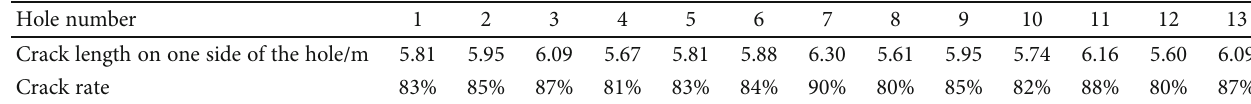
Table 3: The crack rates of the 13 blastholes in SCB.